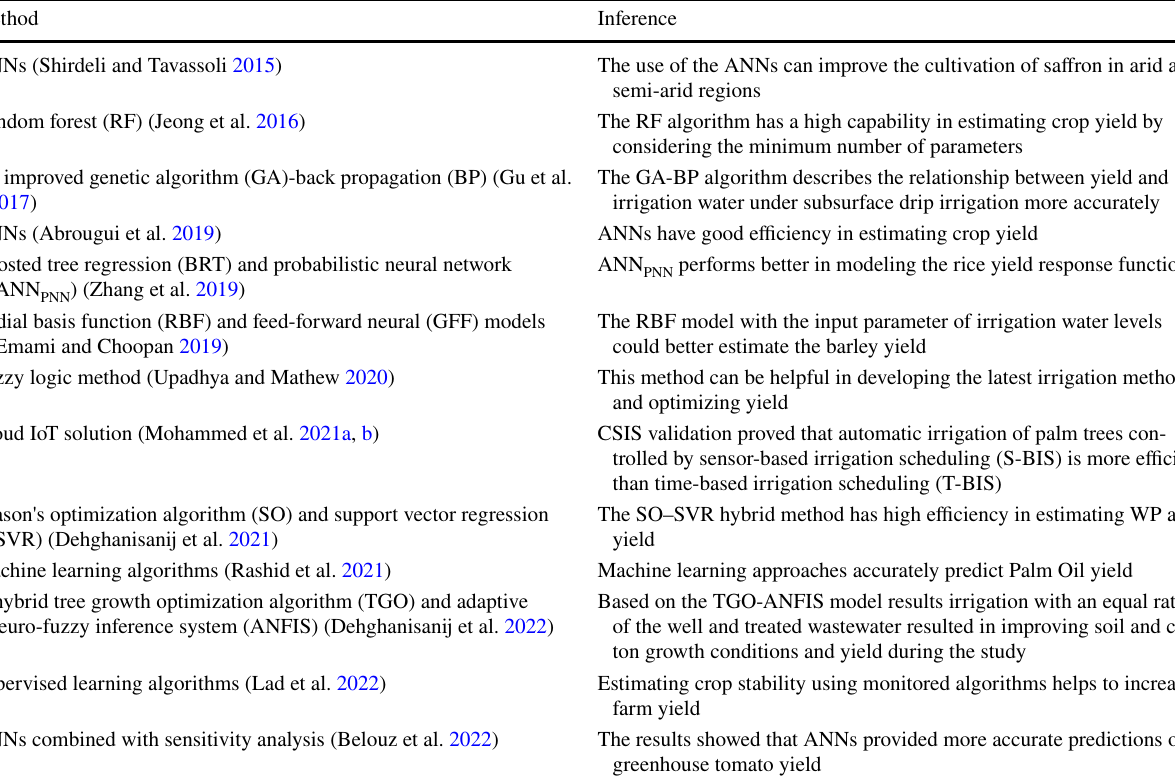
Table 1 Some key points of intelligent methods for estimating yield and WP